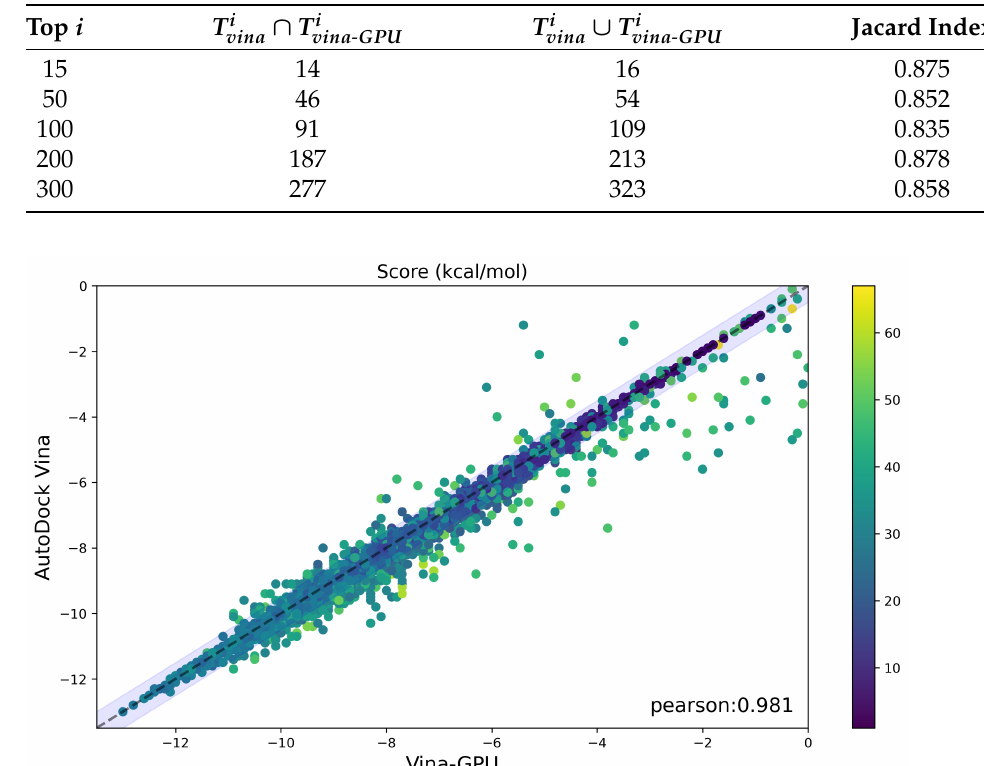
Figure 13. Comparable docking scores between AutoDock Vina and our Vina-GPU on all 9125 com- pounds from the drugbank dataset. The color bar encodes the number of atoms in one ligand. A margin of 0.5 kcal/mol difference on the docking score between AutoDock and our Vina-GPU is highlighted in lavender. The Pearson correlation coefficient of their docking scores is 0.981 (indicated by